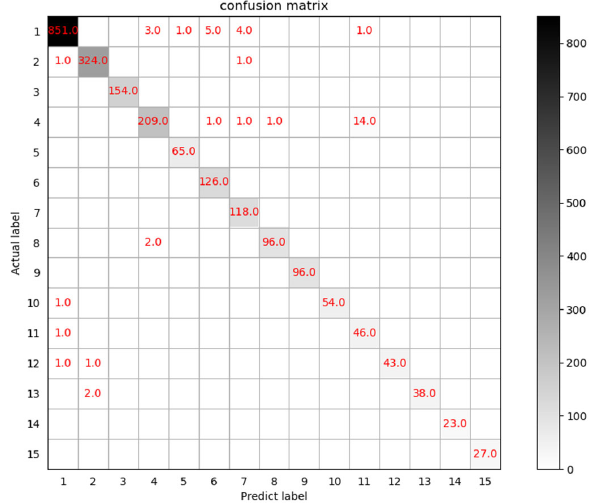
Figure 12. Test result confusion matrix of EBA model on the test set.